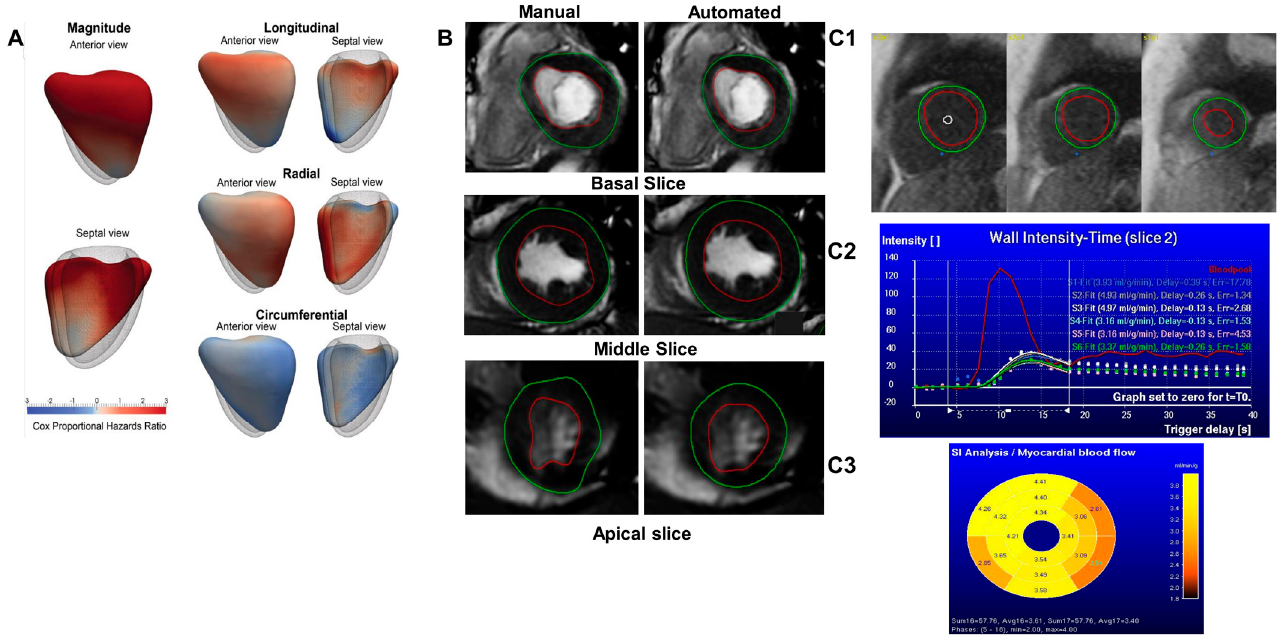
Figure 1. ( A ) A three-dimensional motion assessment model of the right ventricle in pulmonary hypertension illustrates the regional contributions to survival prediction, reproduced with permis- sion from Dawes et al., published by Radiology, RSNA, 2017 [8]. ( B ) A representation of manual vs. automated segmentation of three levels using short-axis cine stack left ventricular (LV) volumetric assessment by cardiac magnetic resonance imaging (CMR). ( C1 ) An automated registration followed by Deep-Learning-based contour detection. LV endocardial border (red), LV epicardial border (green), blood pool (white circle) and right ventricular insertion point (blue dot). ( C2 ) The input function derived from the most basal slice using absolute perfusion quantification by Fermi-based deconvolution. ( C3 ) A bullseye plot showing the results of segmental absolute perfusion quantifi- cation.